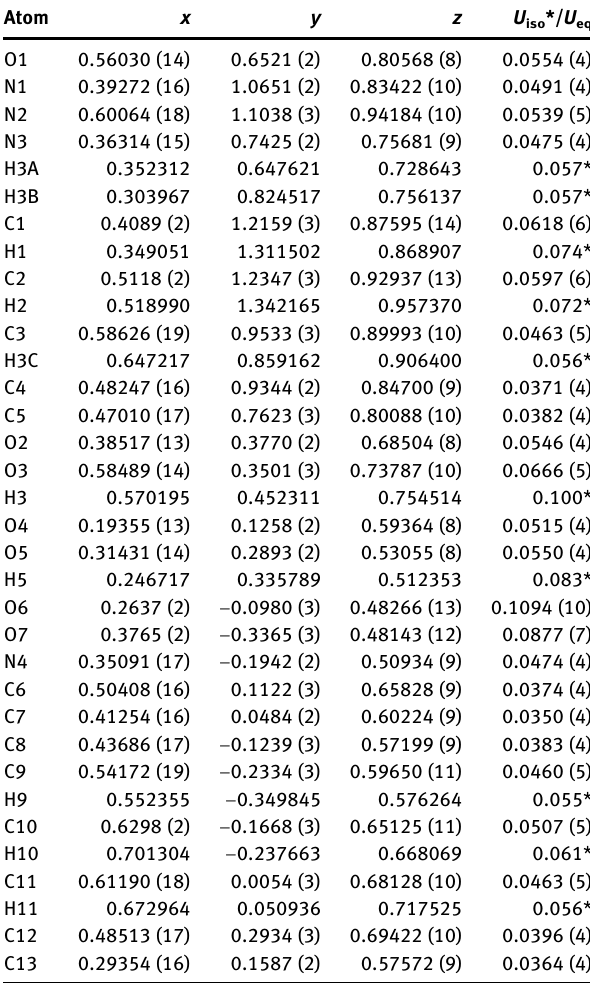
Table  : Fractional atomic coordinates and isotropic or equivalent isotropic displacement parameters (Å 